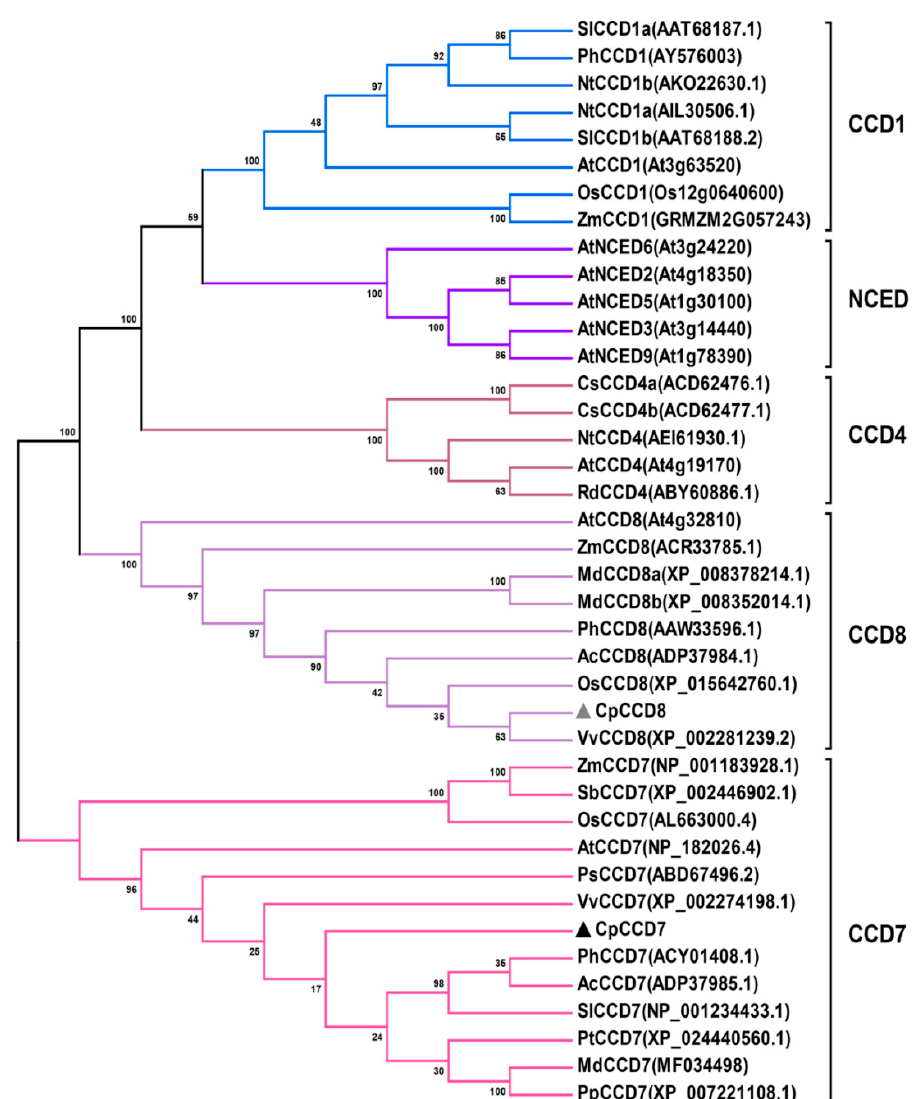
Figure 2. Phylogenetic analysis of CCD family proteins belonging to different plant species. The deduced amino acid sequences of CCD family proteins were aligned using ClustalW in BioEdit Sequence Alignment Editor. Phylogenetic tree was constructed using the neighbor joining (NJ) method, with 1000 bootstrap replicates, using MEGA6.0. At, Arabidopsis thaliana ; Os, Oryza sativa ; Ph, Petunia hybrida ; Zm, Zea mays ; Nt, Nicotiana tabacum ; Sl, Solanum lycopersicum ; Pt, Populus trichocarpa ; Vv, Vitis vinifera ; Ac, Actinidia chinensis ; Pp, Prunus persica ; Rd, Rosa damascene ; Cs, Crocus sativus ; Ps, Pisum sativum ; Md, Malus domestica ; Sb, Sorghum bicolor . CpCCD7 and CpCCD8 are marked with gray and black triangles, respectively.